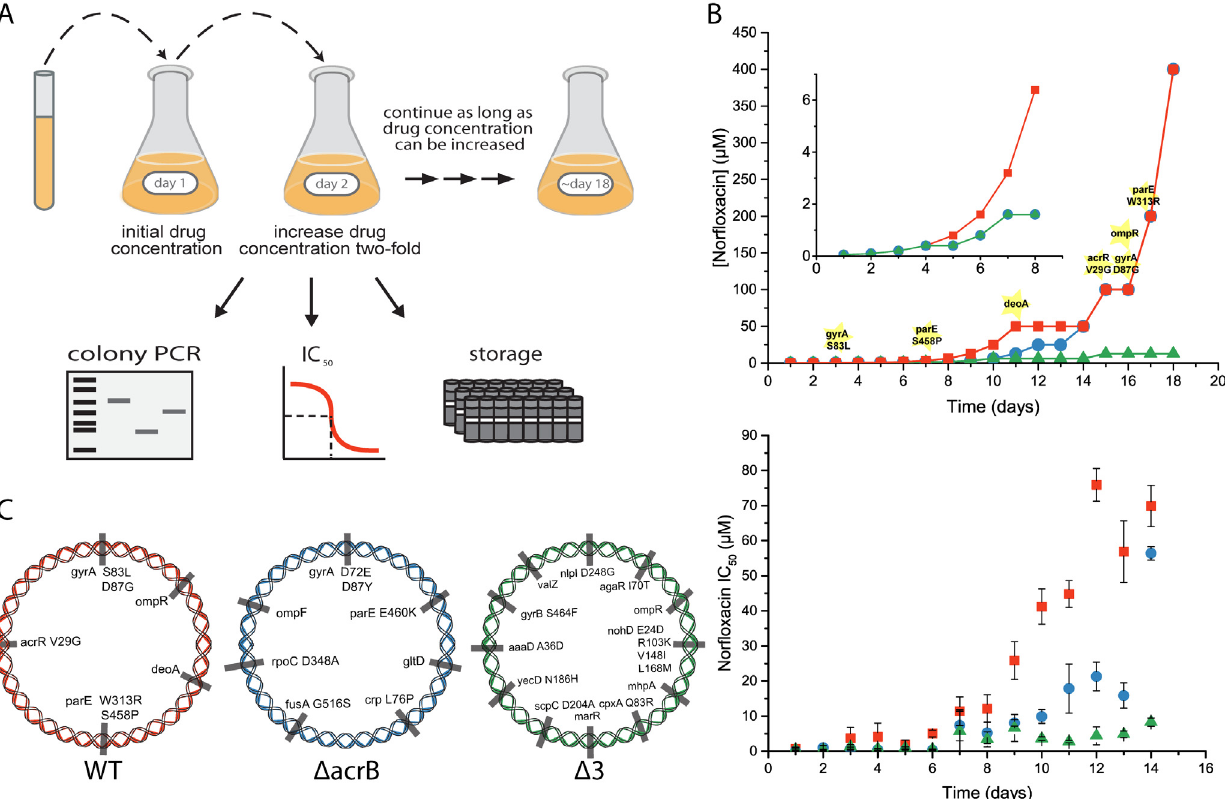
Fig 1. Experimental design for the evolution of high-level resistance to norfloxacin. A. Cells were grown overnight in the presence of 0.05 μ M norfloxacin and cultures that reached at least A 600 = 1 were further diluted to LB-KP i containing twice the norfloxacin concentration. The process was continued with a daily two-fold increase in the norfloxacin concentration for 18 days till the concentration (400 μ M) could no longer be increased because of solubility problems. Throughout the evolution process, all strains were stored, tested daily using PCR to verify the stability of all knockouts and IC 50 values were determined. B top : Time course of the experiment with wild type (red), Δ acrB (blue) and Δ 3 ( Δ mdfA , Δ mdtM and Δ emrE , green); the mutations appearing during the experiment in the wild type strain are highlighted; B bottom : IC 50 values for each strain determined daily. The IC 50 values for days 14 – 18 are not shown because inhibition of growth of WT and Δ acrB strains was too low for accurate determination and they are, at least, 400 μ M. C: Mutations identified in the genome of each one of the strains at the end of the evolution process.